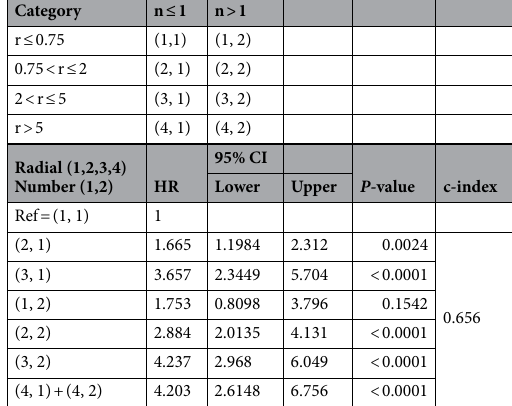
Category n ≤ 1 n > 1 r ≤